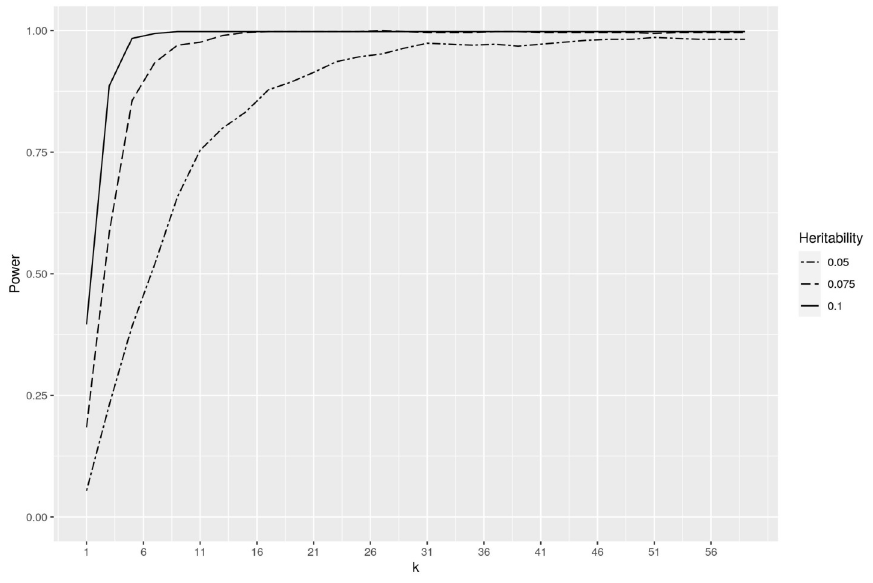
Figure 4. Analysis of simulated datasets for parameter setting of k